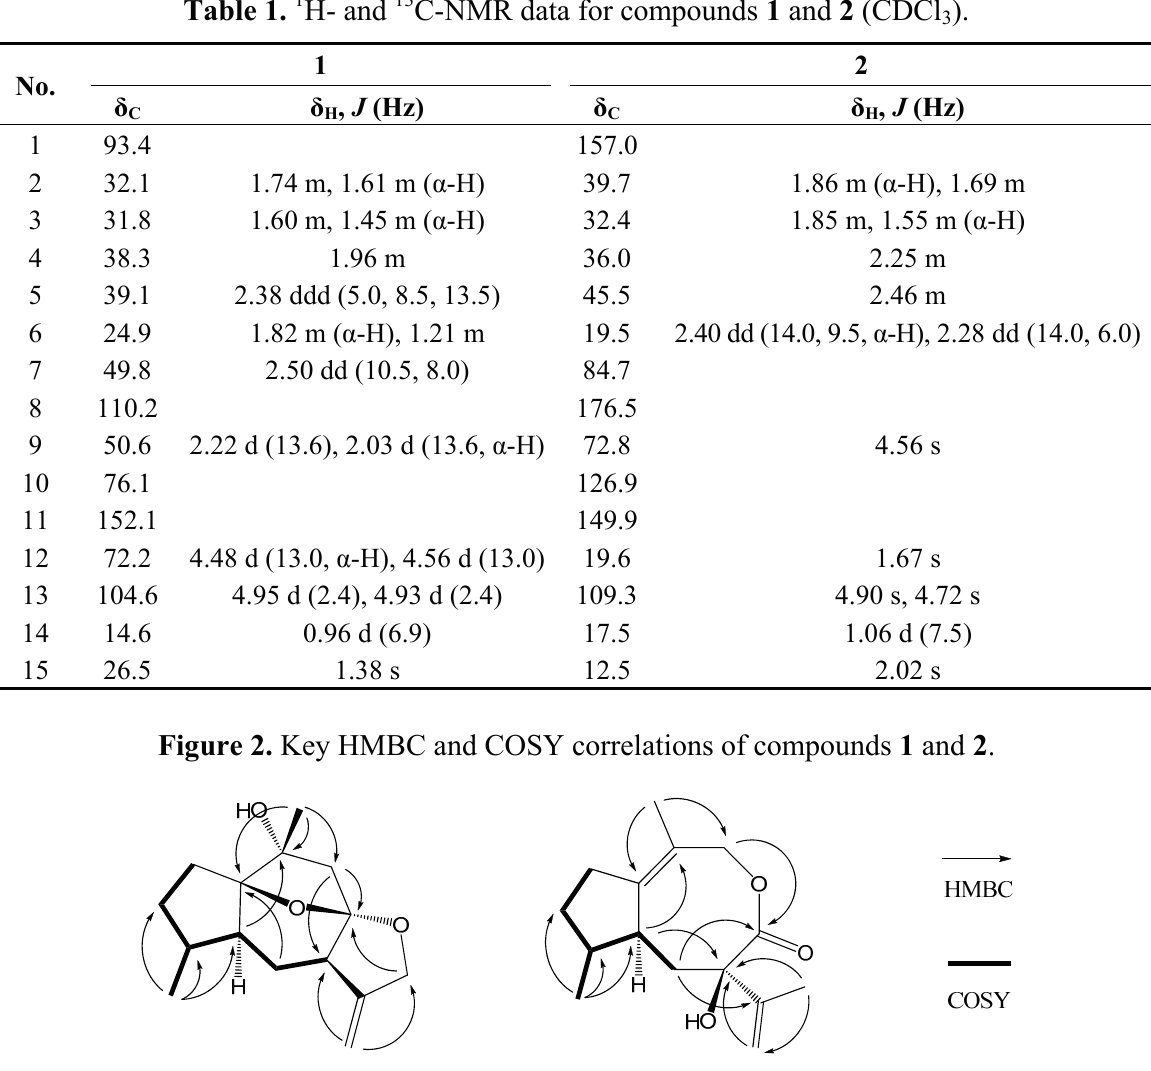
Table 1. 1 H- and 13 C-NMR data for compounds 1 and 2 (CDCl